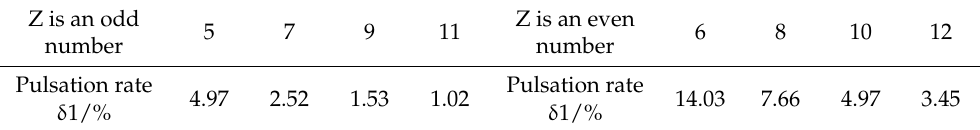
Table 1. Output flow pulsation rates of axial piston pumps. Z is an odd number